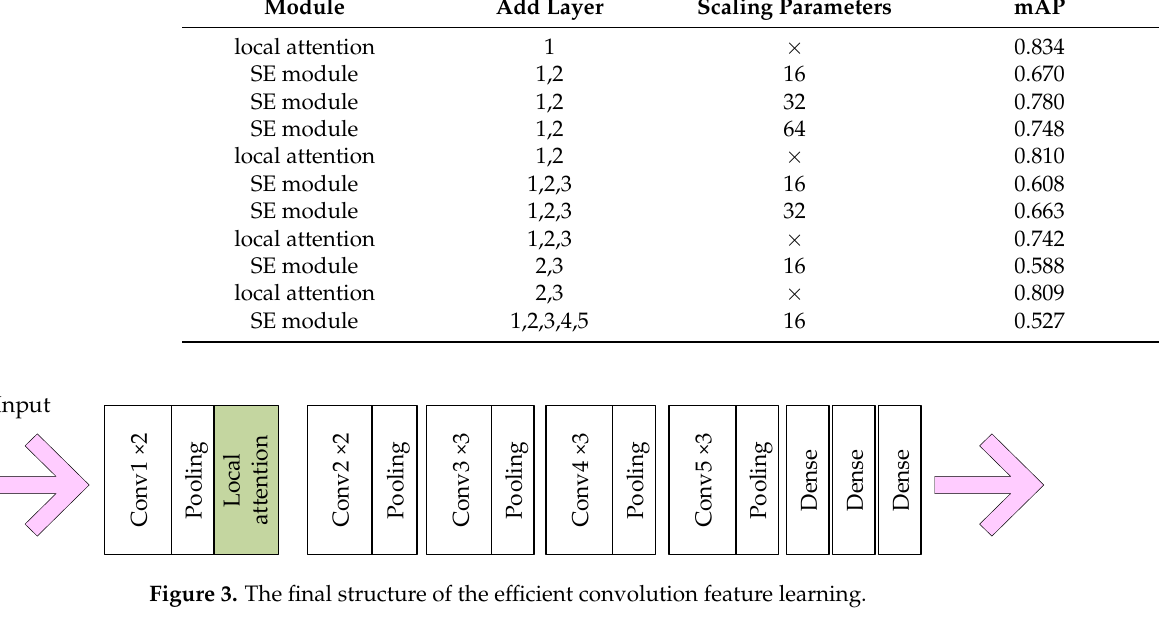
Figure 3. The final structure of the efficient convolution feature learning.